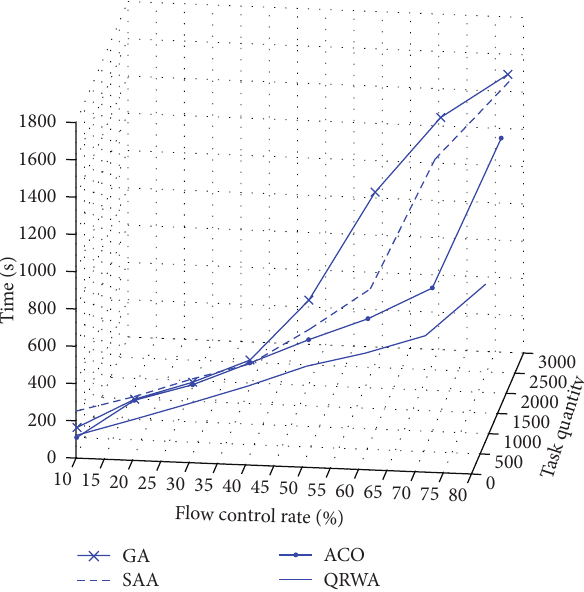
Figure 4: In SUN SPARC Enterprise T5120, the relationship of the flow control rate, task quantity and time. And the QRWA is better than GA, SAA, and ACO.